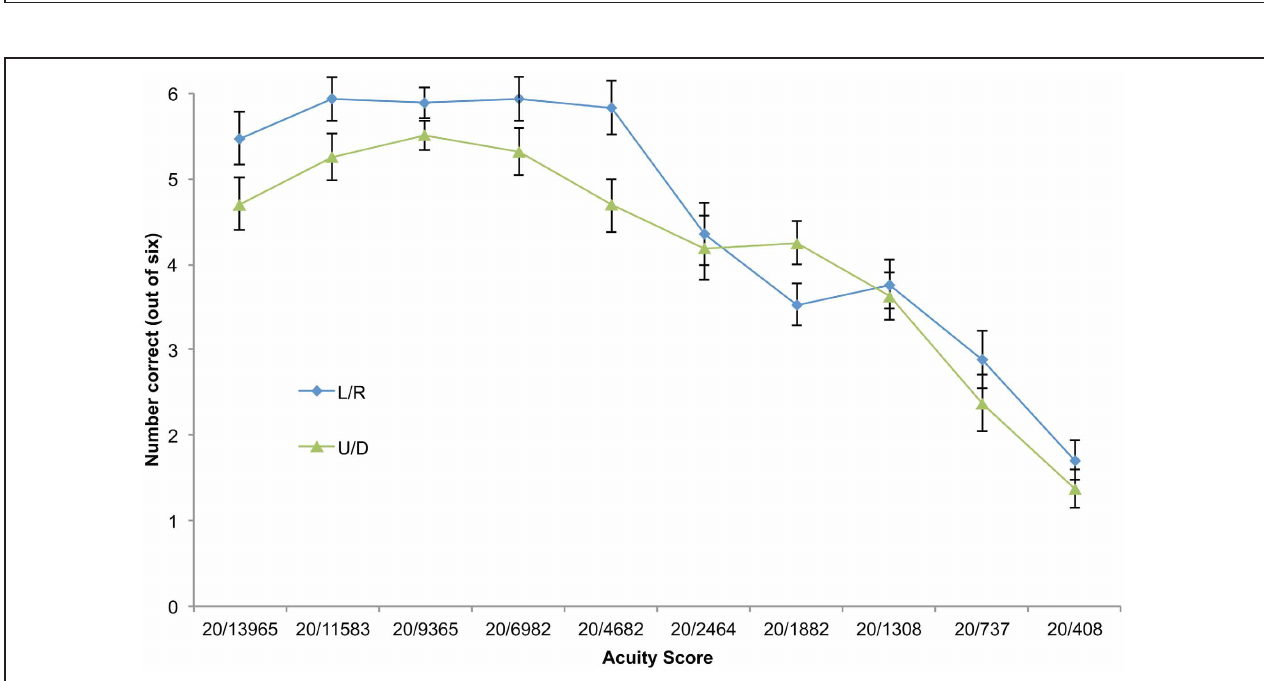
FIGURE 7 | Difference in performance between up/down (U/D) and left/right (L/R) static optotype orientation. Orientation categories shown as functions of increasing acuity score (correct responses out of six, i.e., half the total number of trials per block). Error bars represent standard error of the mean.